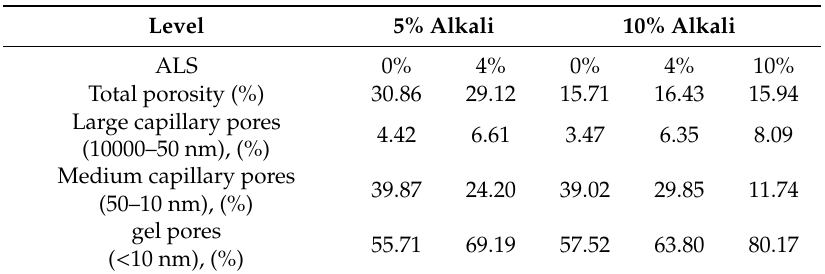
Table 3. Pore size